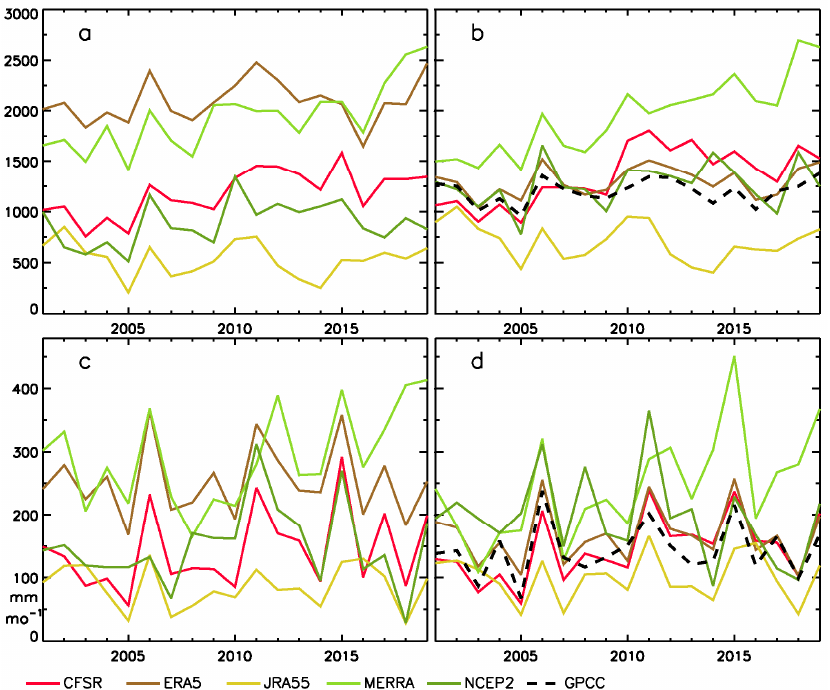
Figure 15. Interannual variability of rainfall (mm/yr or mm/mo) based on reanalysis products: ( a ) Lake Victoria, annual, ( b ) catchment, annual, ( c ) Lake Victoria, November, ( d ) catchment, November.